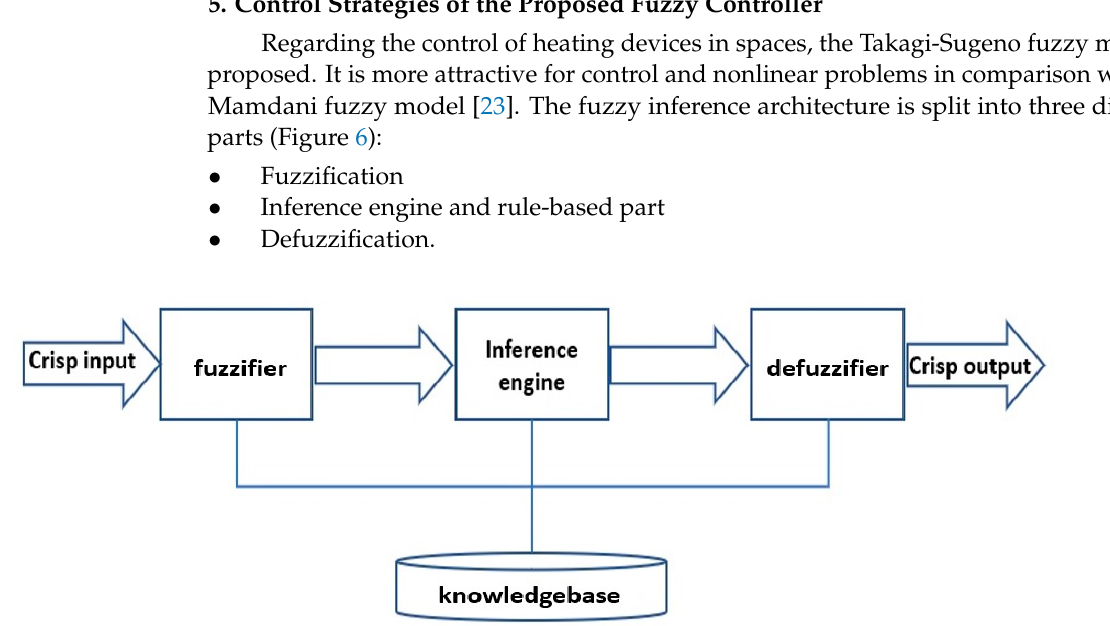
(6) Figure 7. Membership functions of the volume of the living space ( V LS ). S: small, M: medium, and L: large.